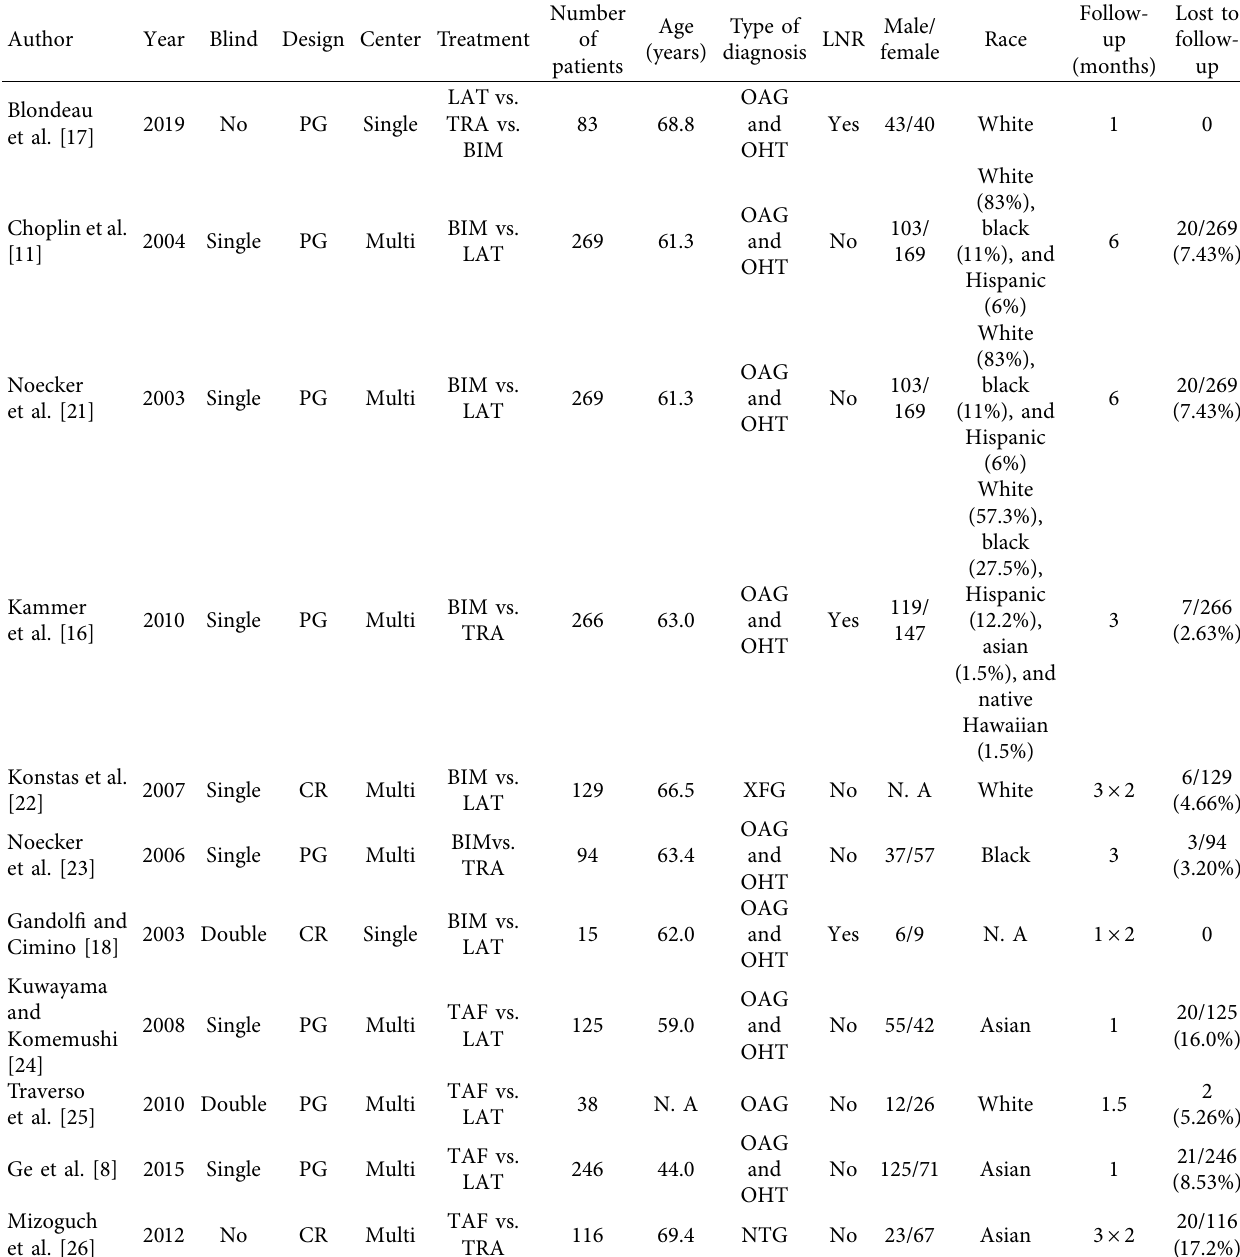
Table 1: Characteristics of studies included in the